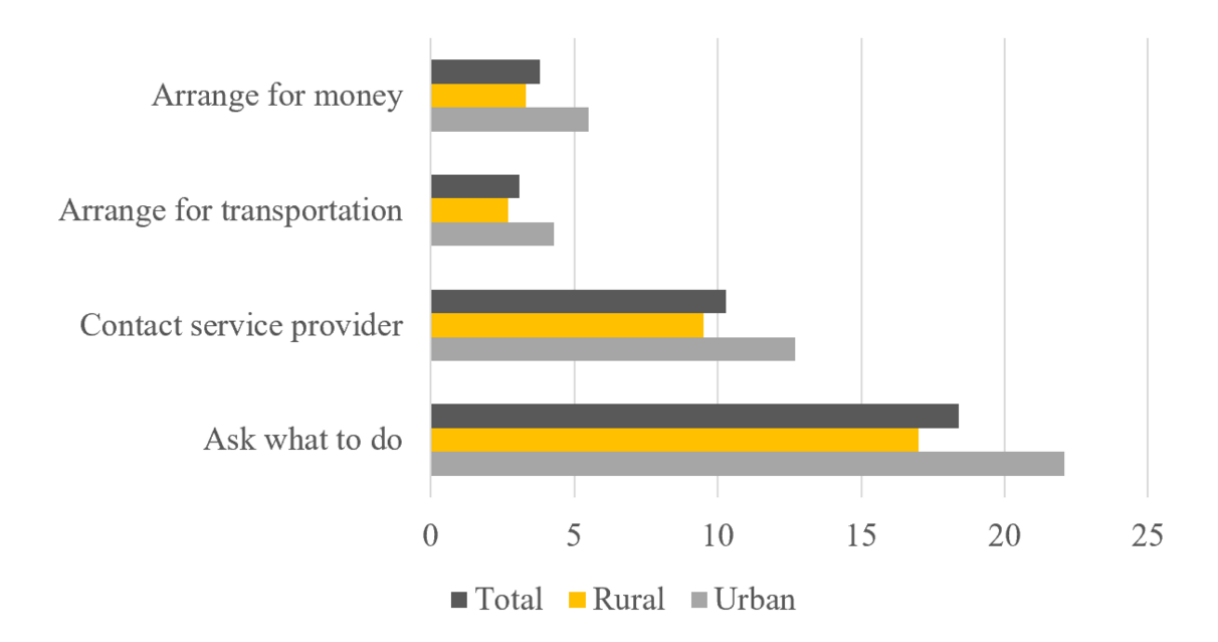
Figure 2. Self-reported purposes (%) for using mobile phone among participants. BDHS